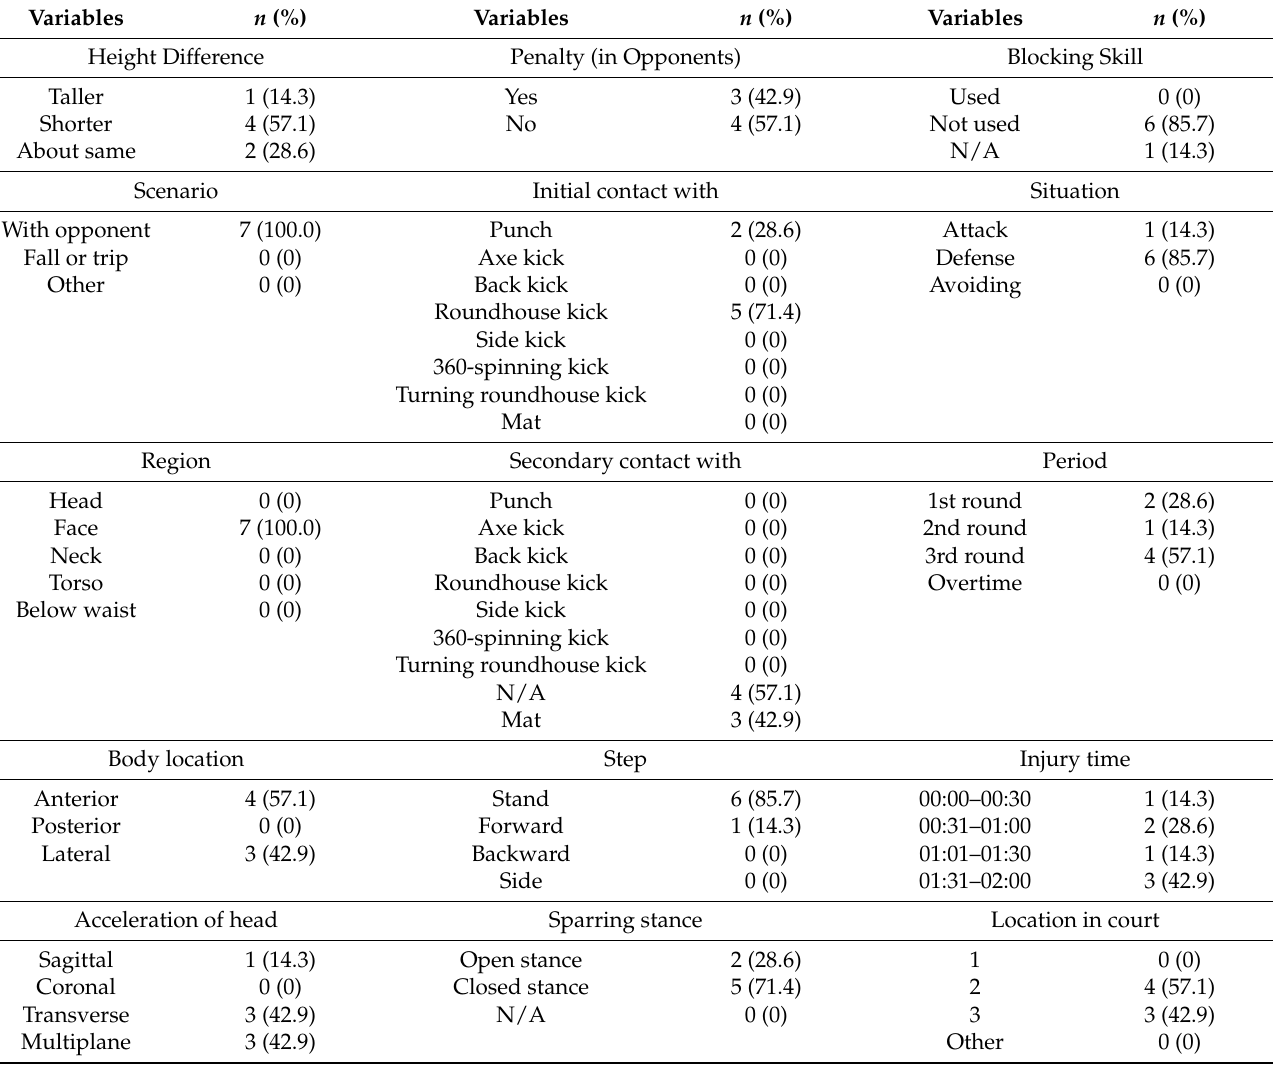
Table 1. Frequency distribution and percentage of variables for concussion events during Taekwondo sparring in the concussed